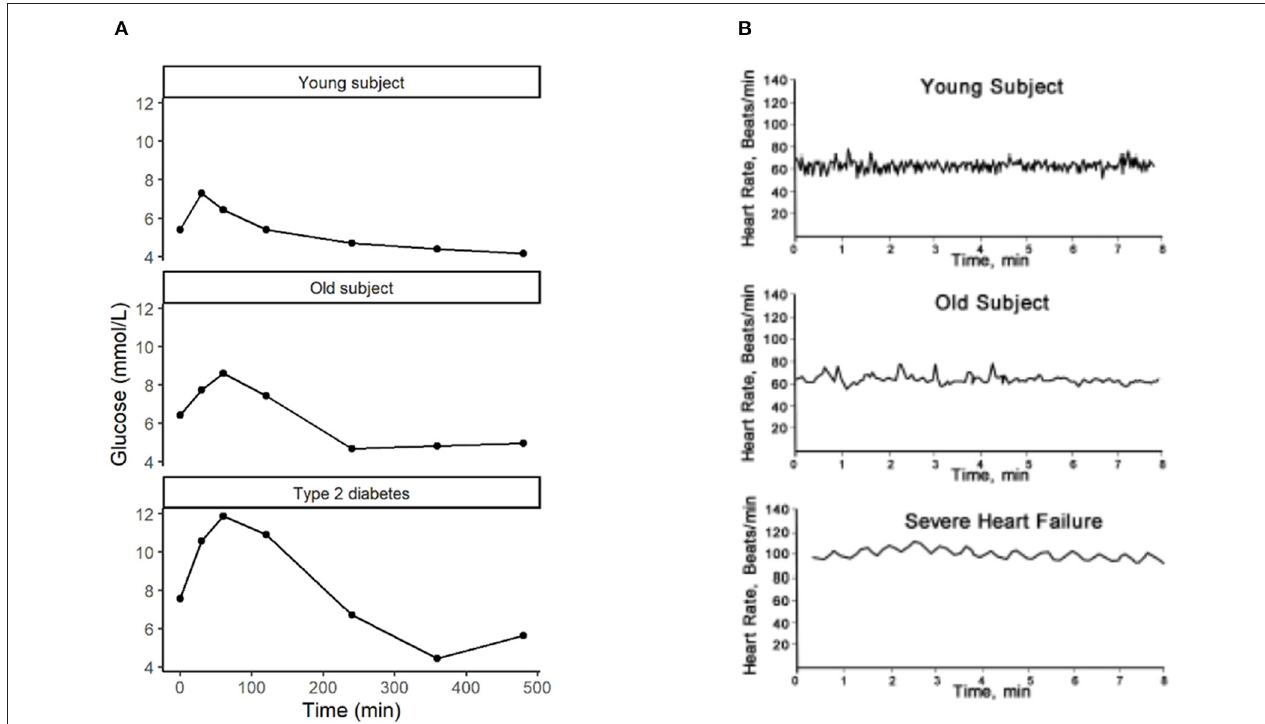
FIGURE 2 | Measures of resilience with (A) the increased response of glucose to a high caloric milkshake with age and disease [data from studies described by Wopereis et al. ( 21) and van den Broek et al. (22)] and (B) the decrease of heart rate variability with age and disease [reprinted with permission from Sturmberg et al.